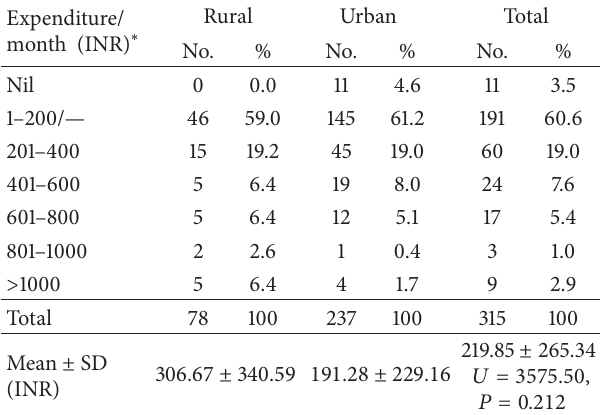
Table 5: Distribution of the study population according to the average total expenditure for treatment of epilepsy ( 𝑛 = 315 ).